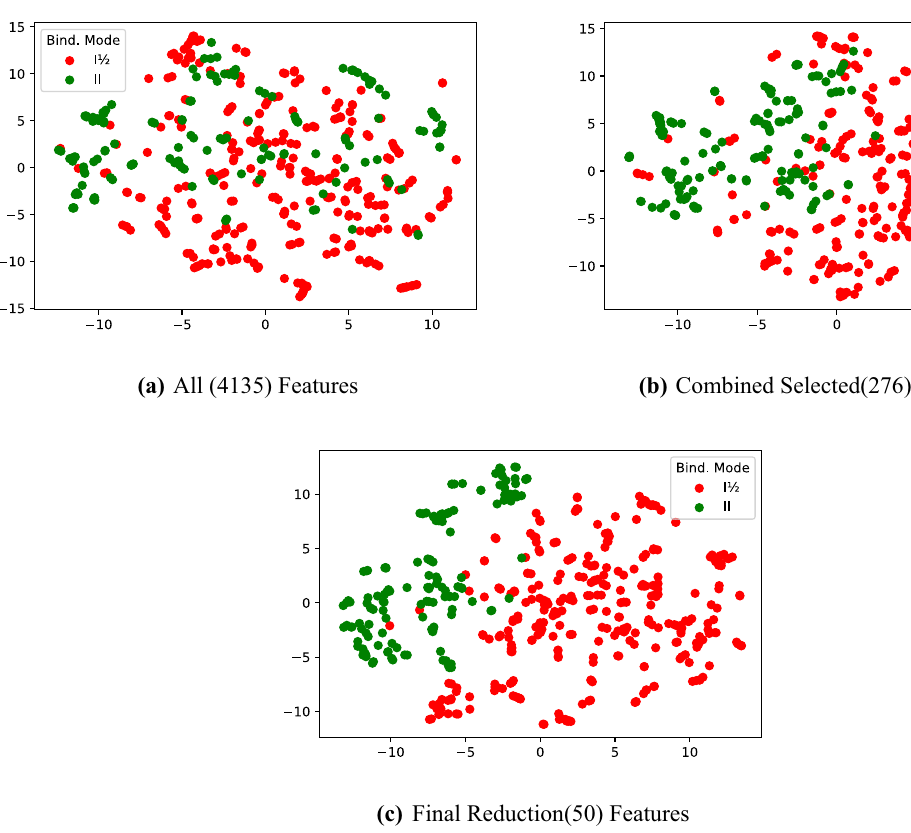
Figure 4. t-SNE plots for the features in classification task CT II selected: 276 features, ( c ) final reduction: 50 features.